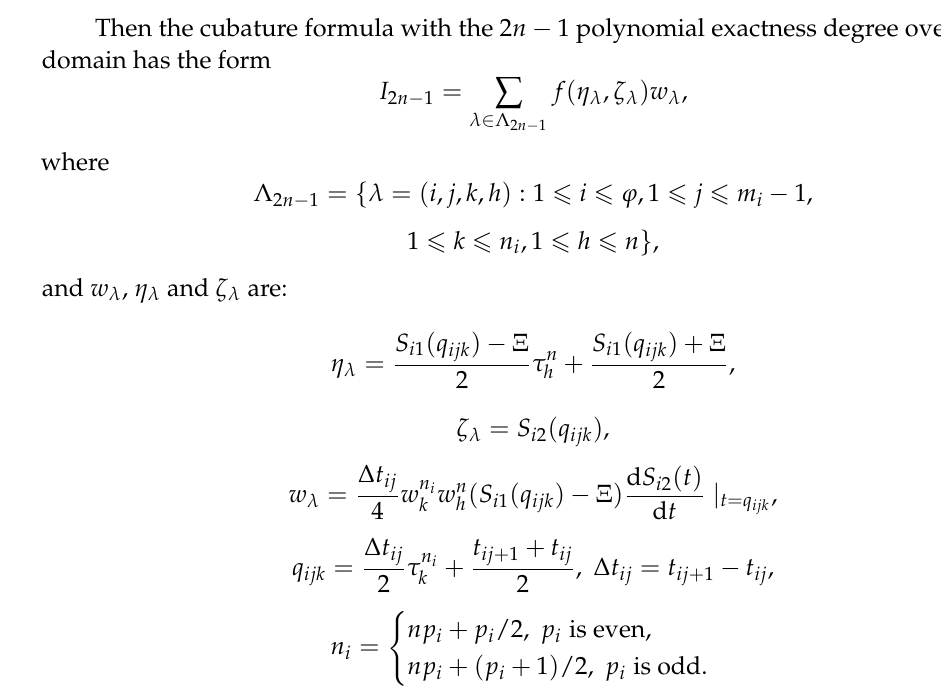
Figure 2. An arbitrary domain in initial and local coordinate